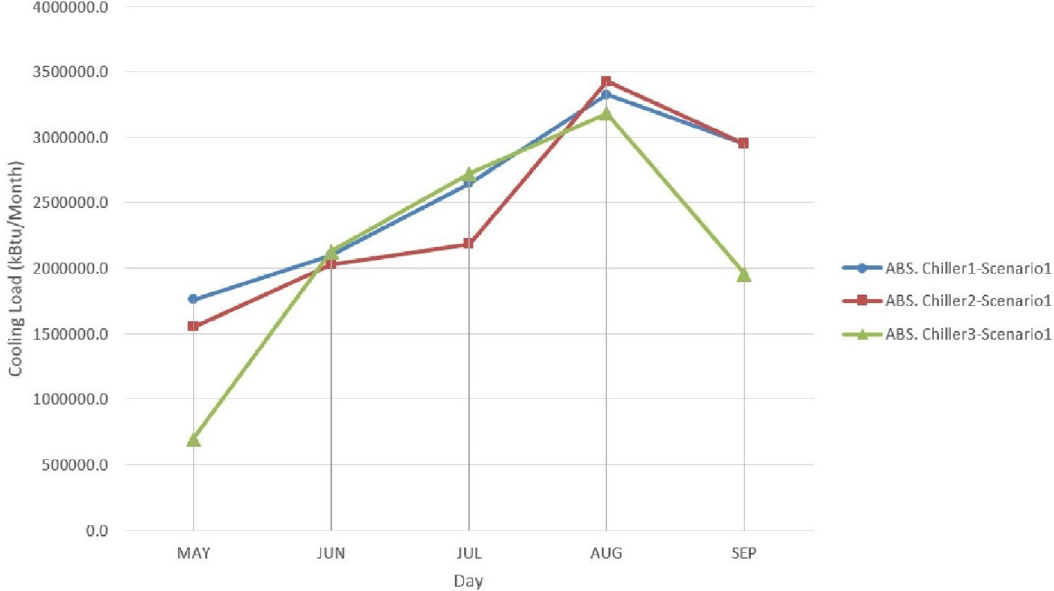
:(min=40 ° F, chws : (min=60 ° F, cws : (min=40 ° F, odb